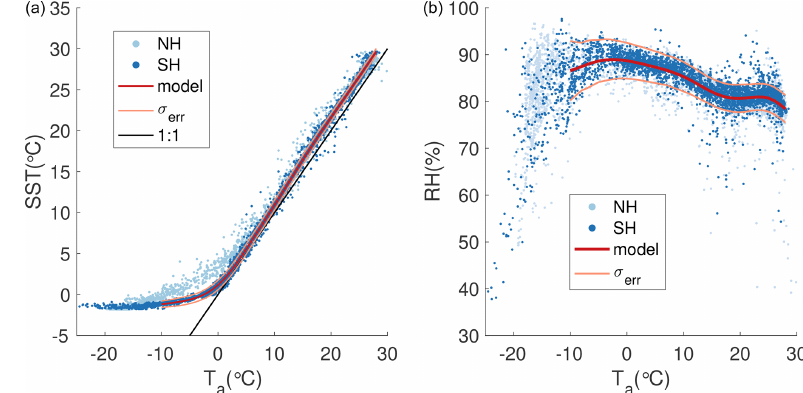
Figure A1. Climatological correlations between T a , SST, and RH. (a) Annual mean climatological surface air temperature, T a , and sea surface temperature, SST, from the NCEP/NCAR reanalysis (Kalnay et al., 1996). Light blue dots are Northern Hemisphere (NH) grid points, while dark blue dots are Southern Hemisphere (SH) grid points. The polynomial fit for the SH is in red. The error estimate for the fit, σ err in orange, is the standard deviation of the misfit in the model. The 1 : 1 line is shown in black. (b) Same as on the left but for the surface air temperature over ocean, T a , and surface relative humidity (RH) over